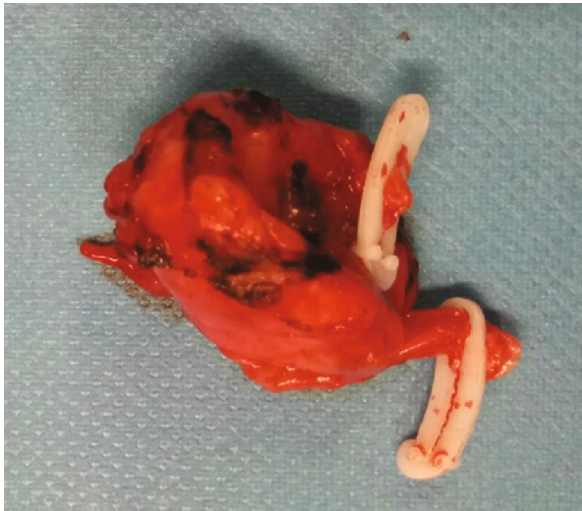
Figure 2: Surgical specimen. Two hemolocks on the e ff erent branches originating in the aneurysmal sac are seen. Anatomopathological study revealed a saccular aneurysm with 28 × 22 × 19mm , with mural thrombus, con fi rming the diagnosis.